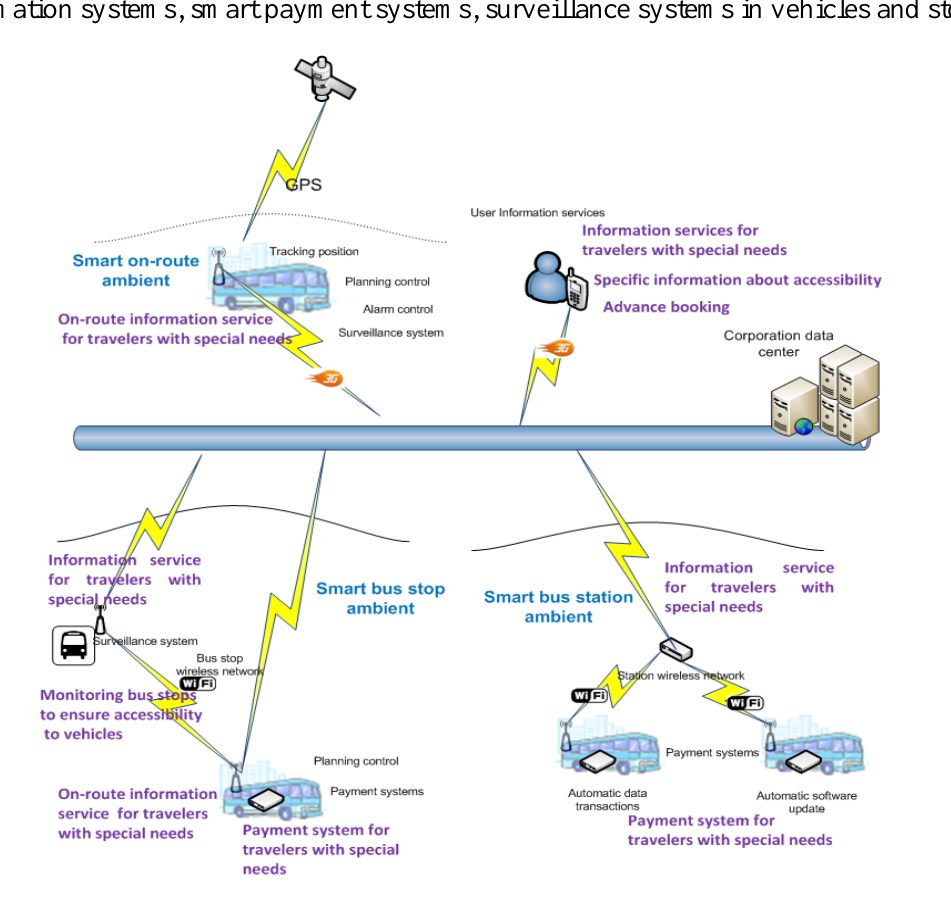
Figure 1. System